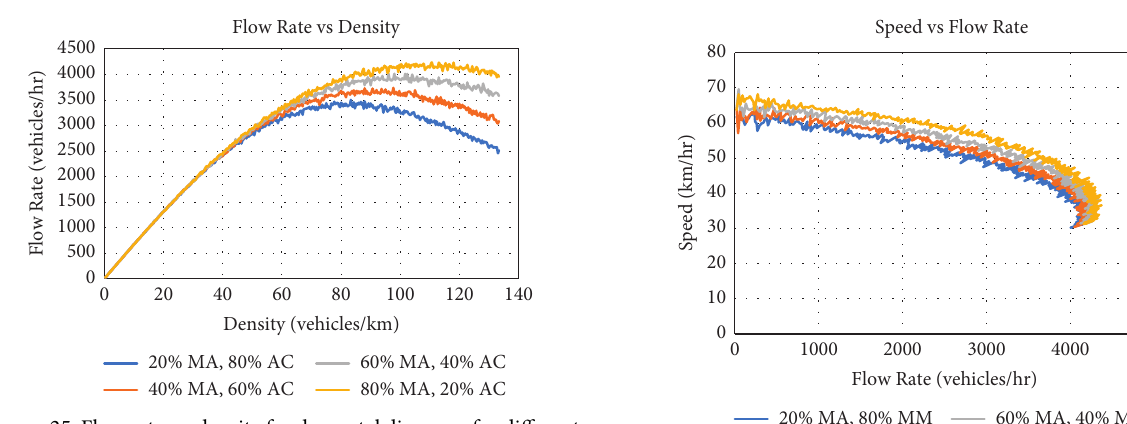
Figure 25: Flow rate vs. density fundamental diagrams for different compositions of MA and